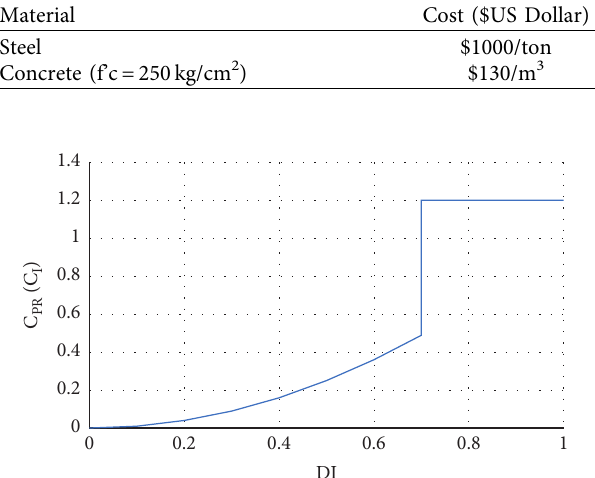
Table 1: Unitary cost of materials.